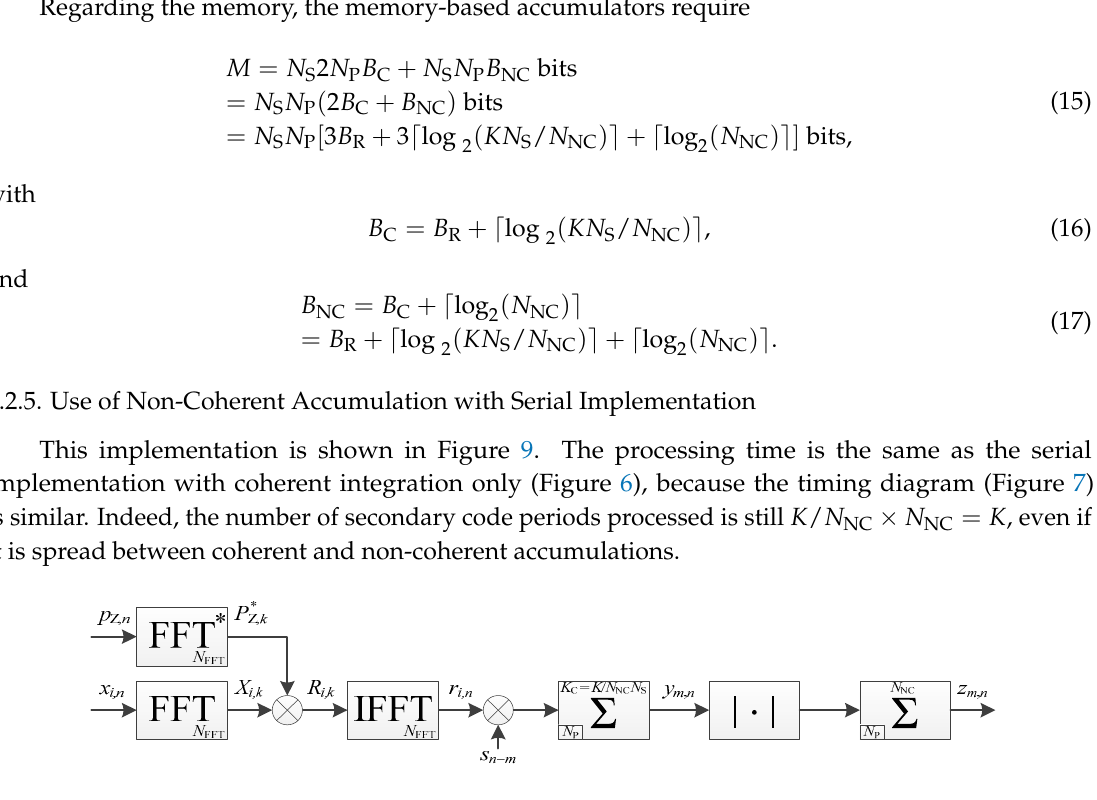
Figure 9. Implementation of a pilot channel acquisition, with non-coherent accumulation, in a serial way (timing diagram available in Figure 7).